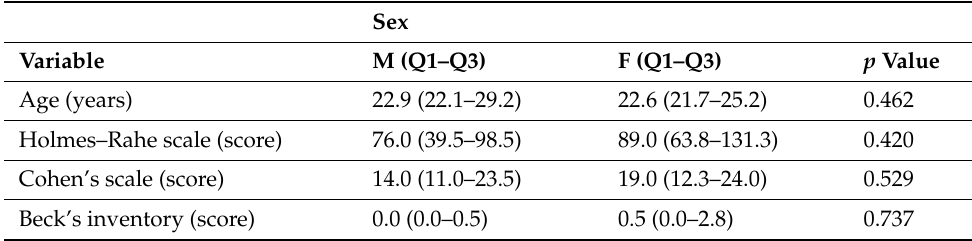
Table 1. Demographic characteristics of participants submitted to CPS